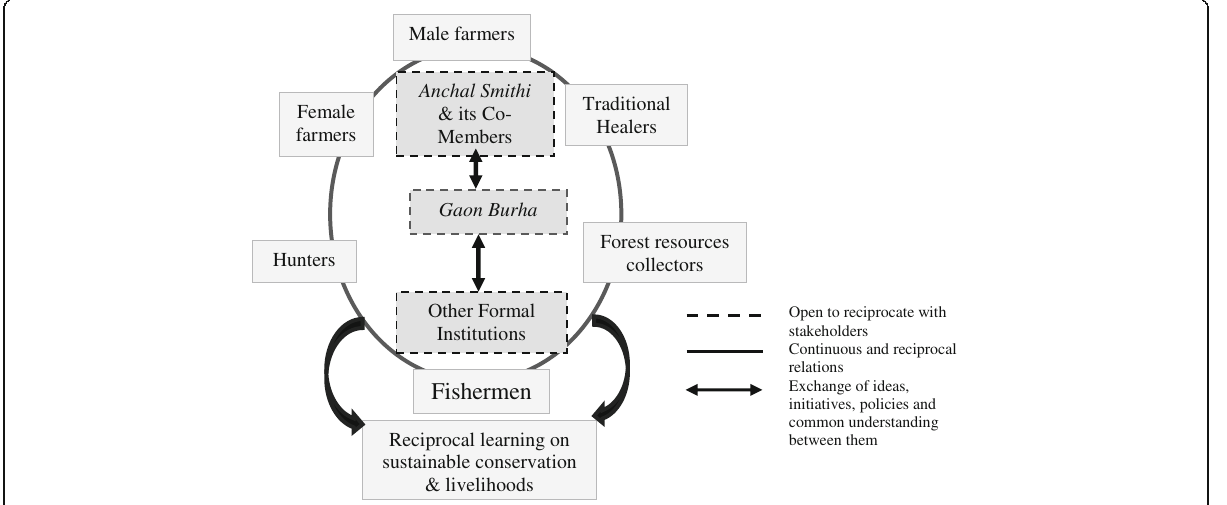
Fig. 3 A thematic diagram showing interrelations of multiple stakeholders in sustainable conservation of forest